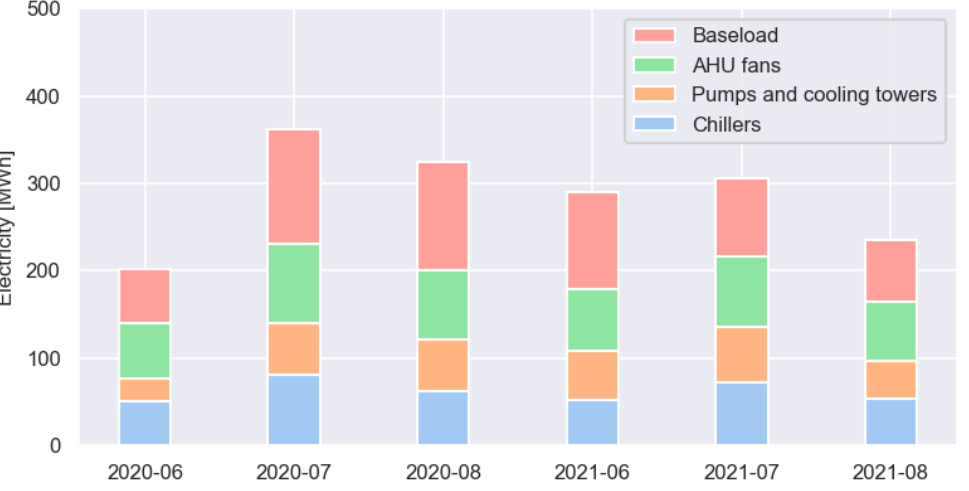
Figure 3. Electricity use of the case study building: “Baseload” refers to the non-HVAC load; “AHU fans” includes all of the fans in the air distribution network; “Pumps and cooling towers” refers to all the pumps in the water network and all the fans in the cooling towers and air-cooled condensers; “Chillers” include all three